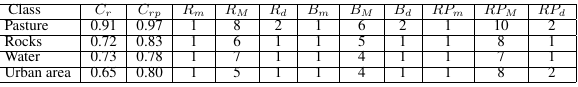
Table 5. Decision covers.